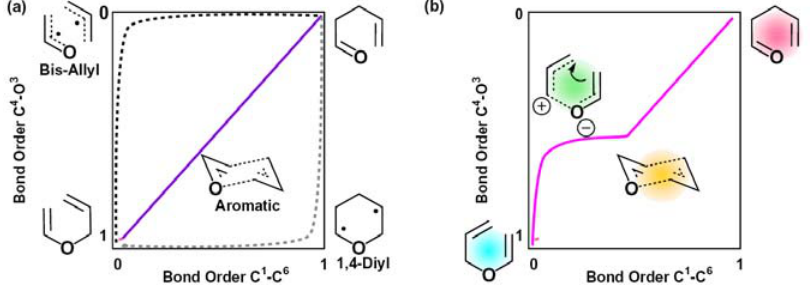
Figure 3. Transition-state profile for the Claisen rearrangement. ( a ) Purple curve: a synchronous concerted pathway reaction via an aromatic-like TS. Black curve: a stepwise pathway reaction via a bis-allyl like TS. Gray curve: a stepwise pathway reaction via a 1-4-diyl like TS; ( b ) Red curve: this work.